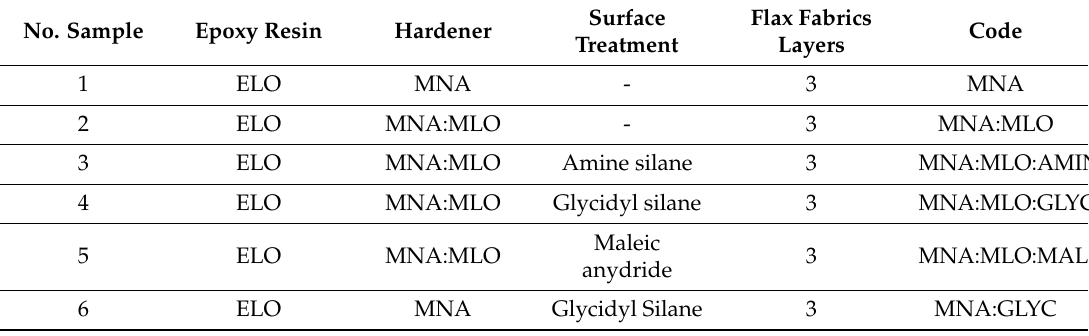
Table 2. Composition and coding of the flax fabric composites with epoxidized linseed oil (ELO) matrix and a mixture of maleinized linseed oil (MLO) and methyl nadic anhydride (MNA) as hardeners. No.